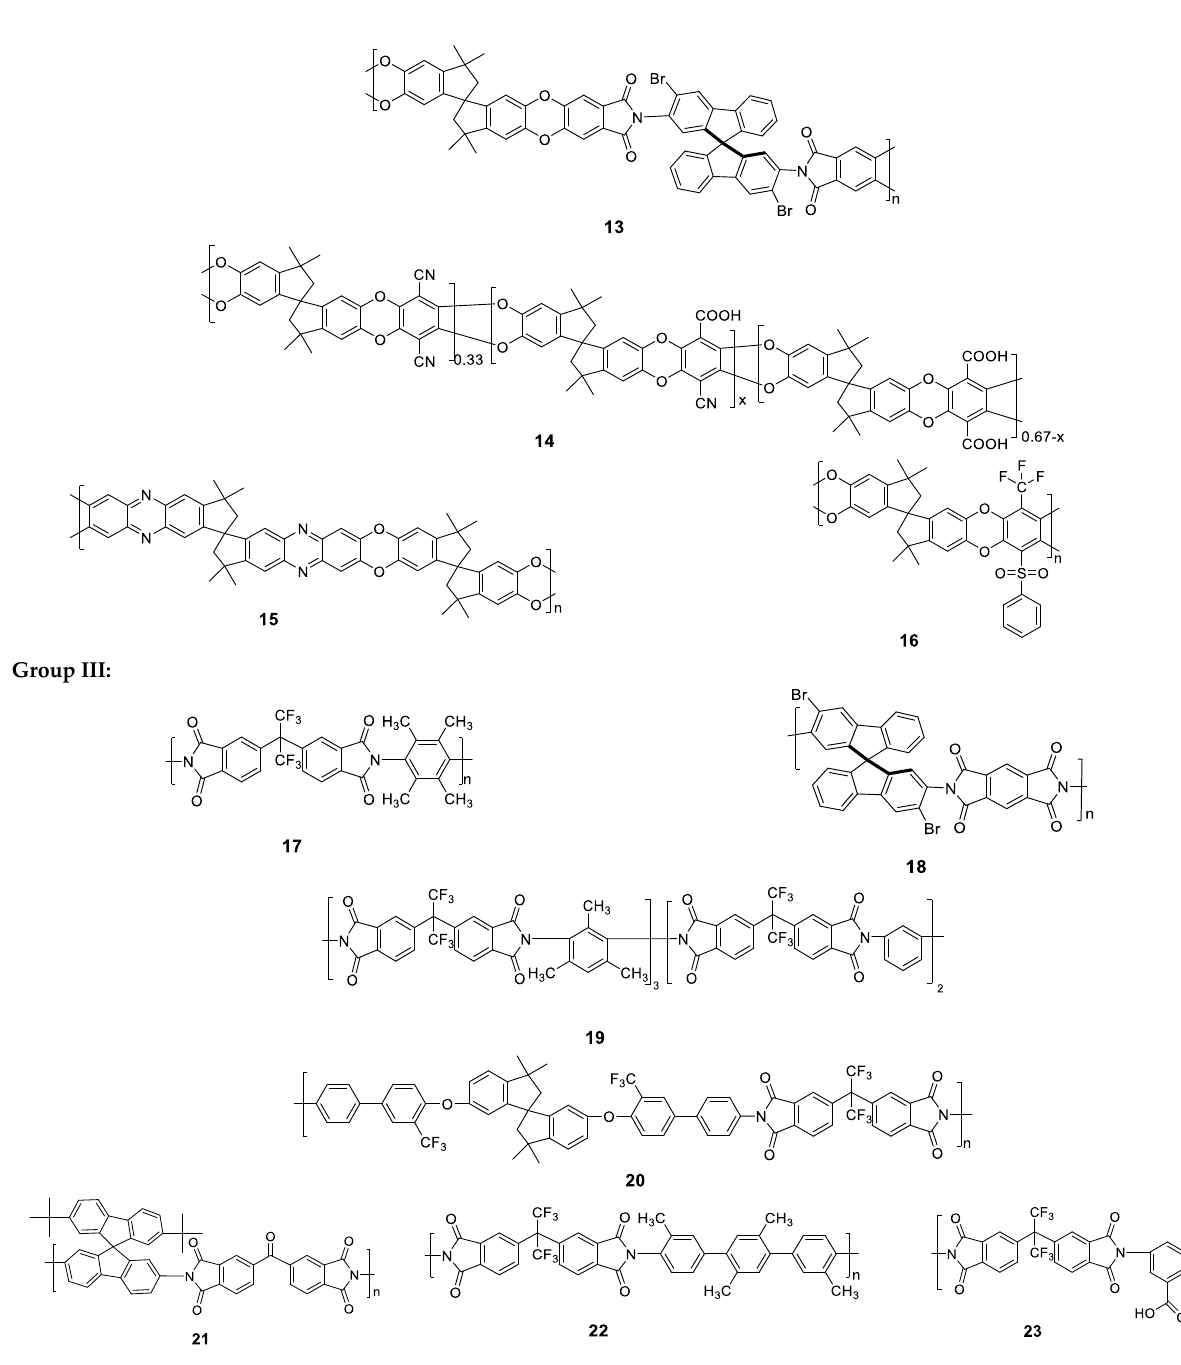
Chart 1. Chemical structures of membrane polymers in Figure 3 (All polymers until 2013).